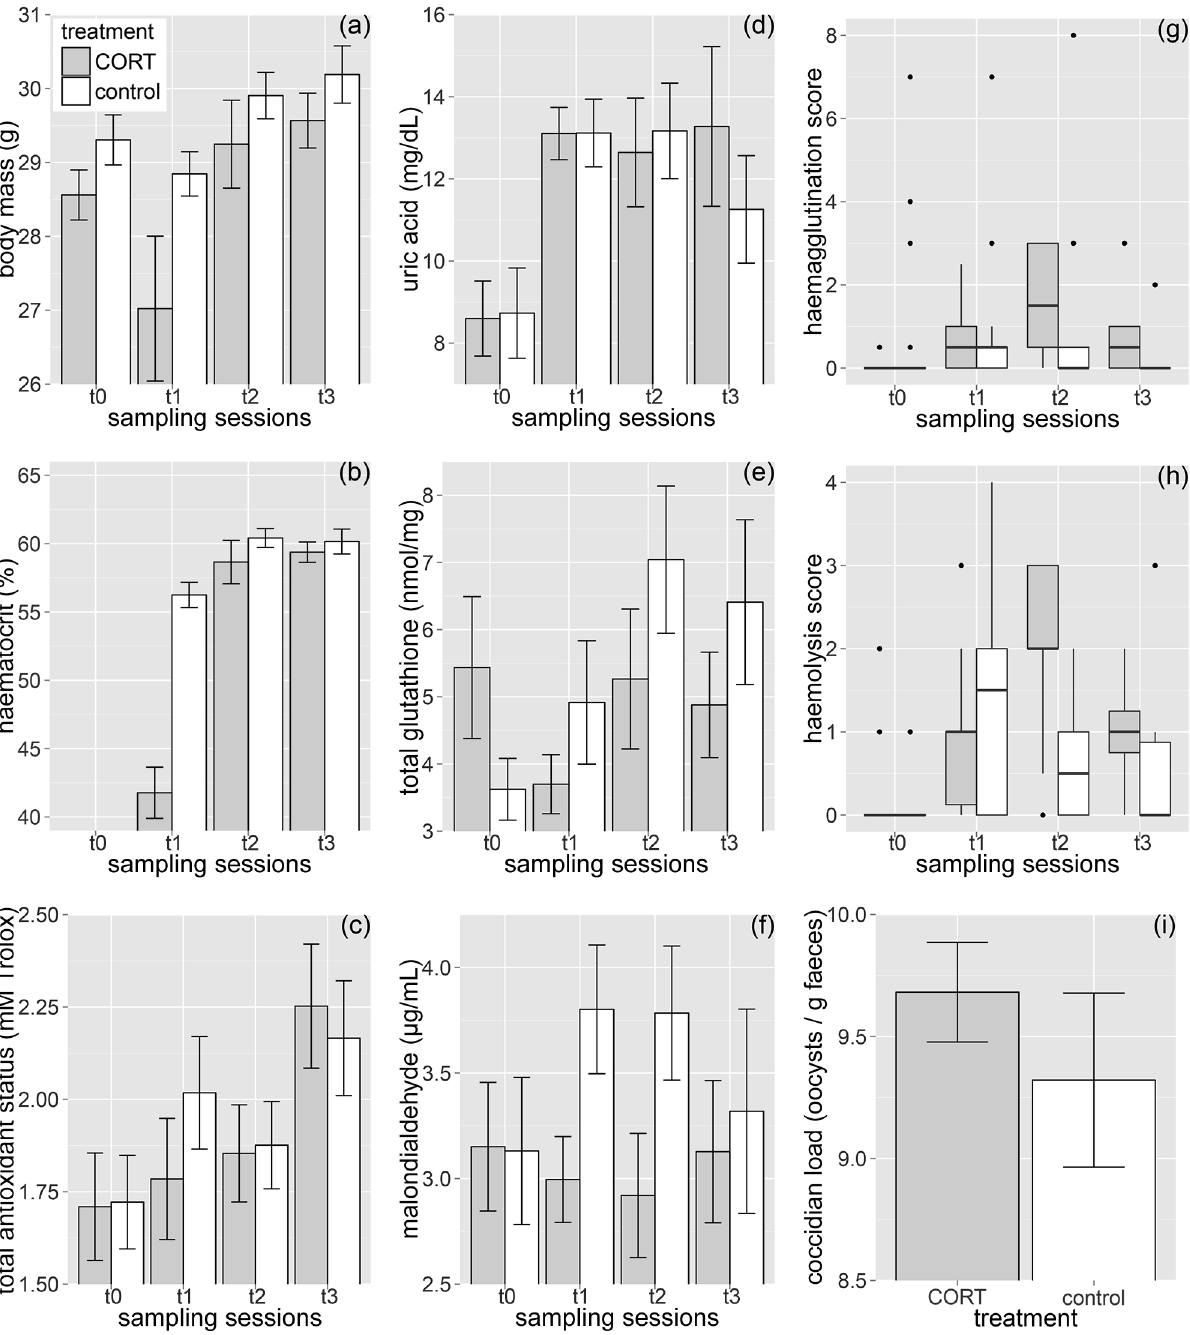
Fig 2. Physiological effects of chronic CORT treatment. The effects of CORT-implantation on (a) body mass, (b) hematocrit, (c) total antioxidant status, (d) uric acid, (e) total glutathione, (f) malondialdehyde, (g) hemagglutination, (h) hemolysis and (i) coccidian infestation in post-molting house sparrows. Sampling sessions: t 0 –pre-treatment, t 1 , t 2 and t 3 –first, second and third post-treatment, respectively. Hematocrit was not measured during the pre-treatment sampling session (but see Materials and methods and Results), while coccidian load was only counted after the termination of the experiment. Mean ± 1 SE are shown throughout, except for panels (g) and (h) where median, inter-quartile range and range are plotted, and dots denote outliers. Body mass and hematocrit was measured for all birds at t 1 , t 2 and t 3 , while samples sizes for oxidative stress and immunity variables are 27 at t 1 , 26 at t 2 and 26 at t 3